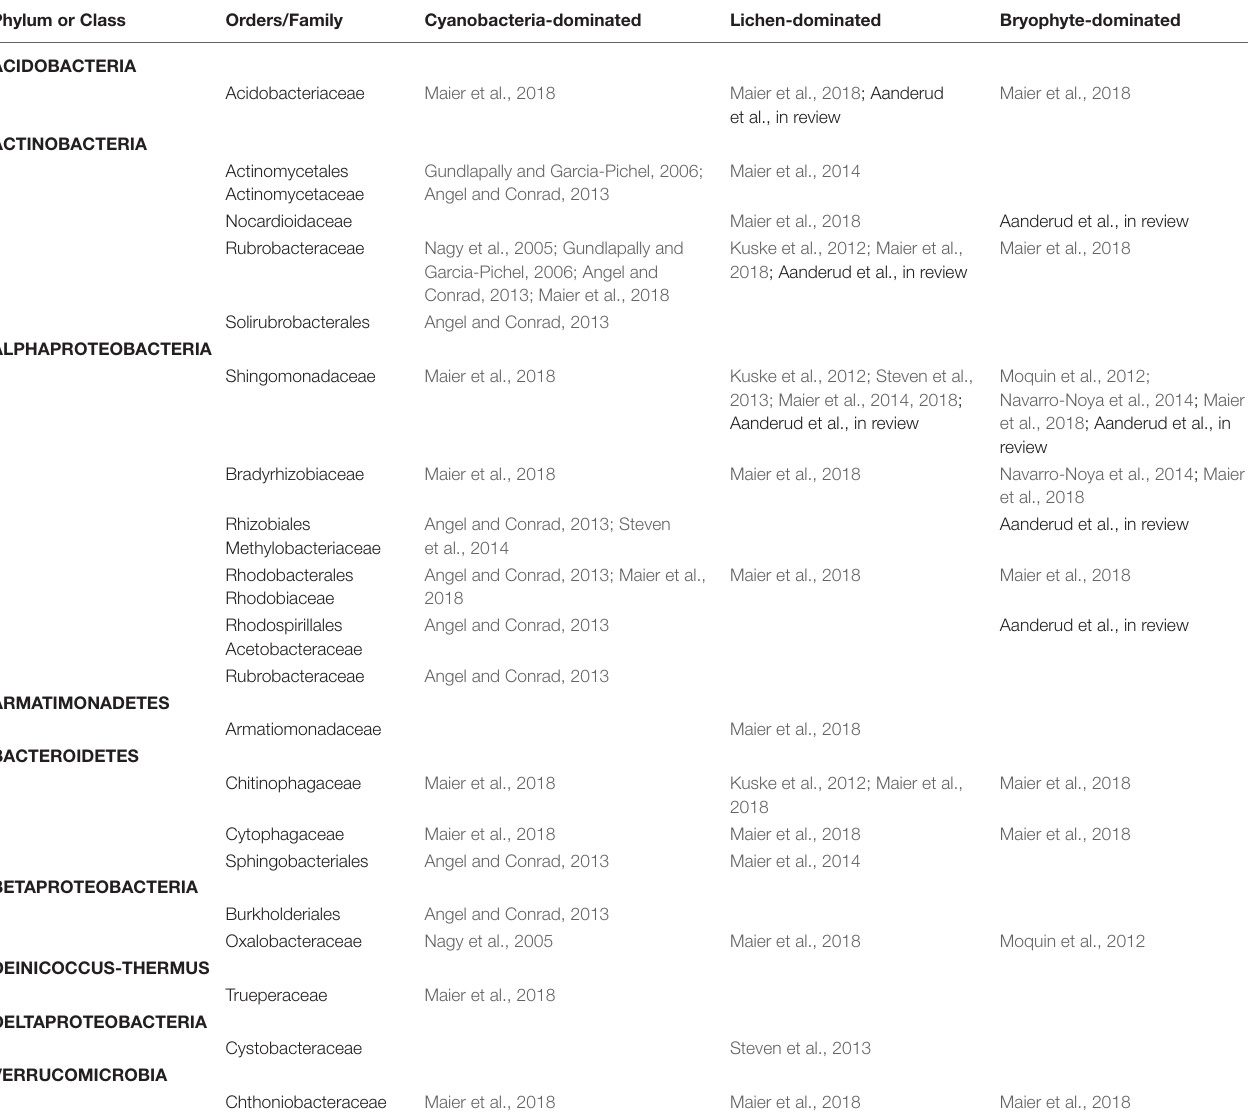
TABLE 1 | Abundant chemoheterotrophic bacterial families/orders in cyanobacteria-dominated, lichen-dominated, and/or bryophyte-dominated biocrusts based on eleven